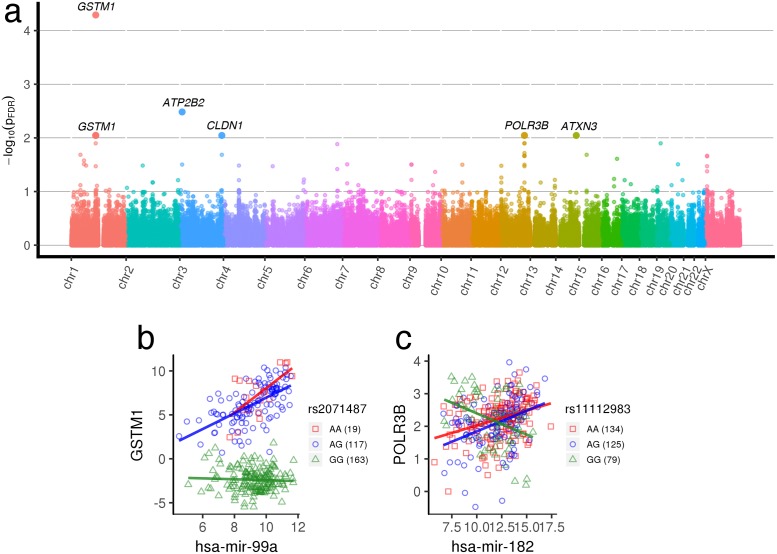
Liver cancer regQTLs.(a) Manhattan plot of regQTL −log10
FDR values in TCGA LIHC data. (b, c) Examples of liver cancer gene-miRNA-SNP trios with significant regulatory differences across genotypes. All trio interactions pFDR < 0.005. More trios are indicated in S1 Text.